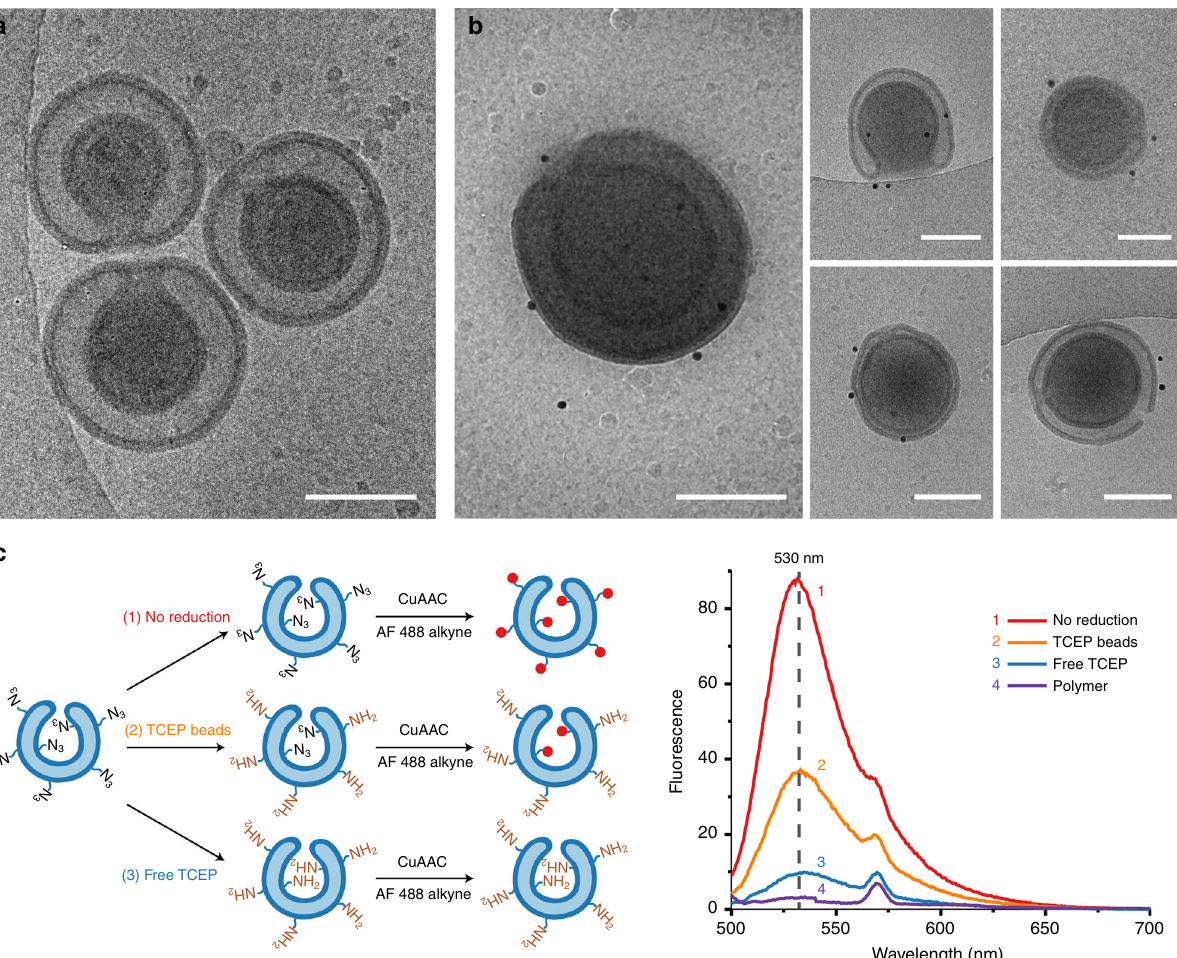
Fig. 2 Characterization of PEG-PDLLA stomatocytes with azide handles. a Cryo-TEM picture of PEG-PDLLA stomatocytes. Scale bar, 250 nm. b Cryo-TEM pictures of PEG-PDLLA stomatocytes after reduction with TCEP beads and subsequent reaction with NHS functionalized gold nanoparticles (20nm), showing binding to the outer surface. Scale bars, 250nm. c Reduction assay; fl uorescence spectra of Alexa Fluor 488-alkyne clicked to available azide groups before and after reduction. 1 (red line) Fluorescence spectrum without reduction, showing maximum fl uorescence signal. 2 (orange line) Fluorescence after reduction with TCEP beads, showing 45% signal, indicating approximately half the azide groups were reduced. 3 (blue line) Fluorescence after reduction with free TCEP, showing 8% signal, showing almost complete reduction. 4 (purple line) Fluorescence signal of polymer only as negative